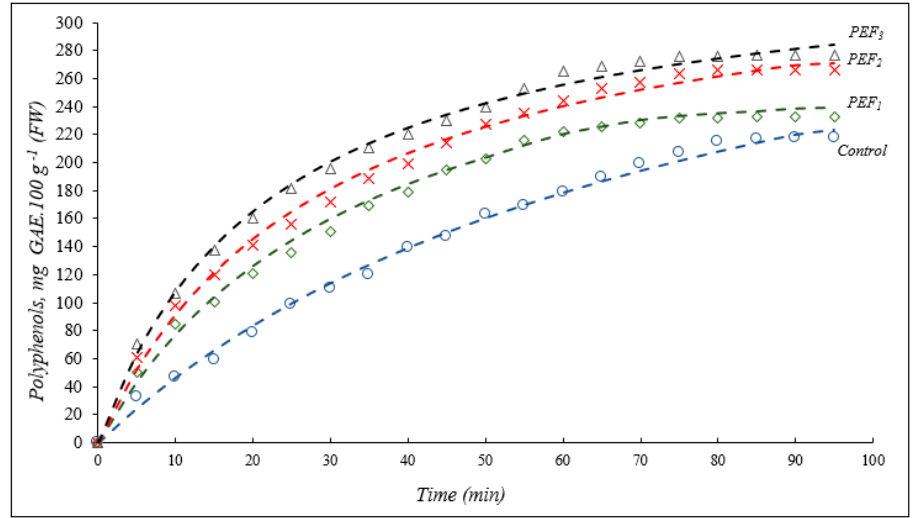
Figure 3. Effect of different treatments of PEF (E 1 = 1 KV.cm − 1 , E 2 = 2 KV.cm − 1 , and E 3 = 2.5 KV.cm − 1 ) on the polyphenolics extraction during diffusion at 40 °C (Each experiment was repeated three times) .